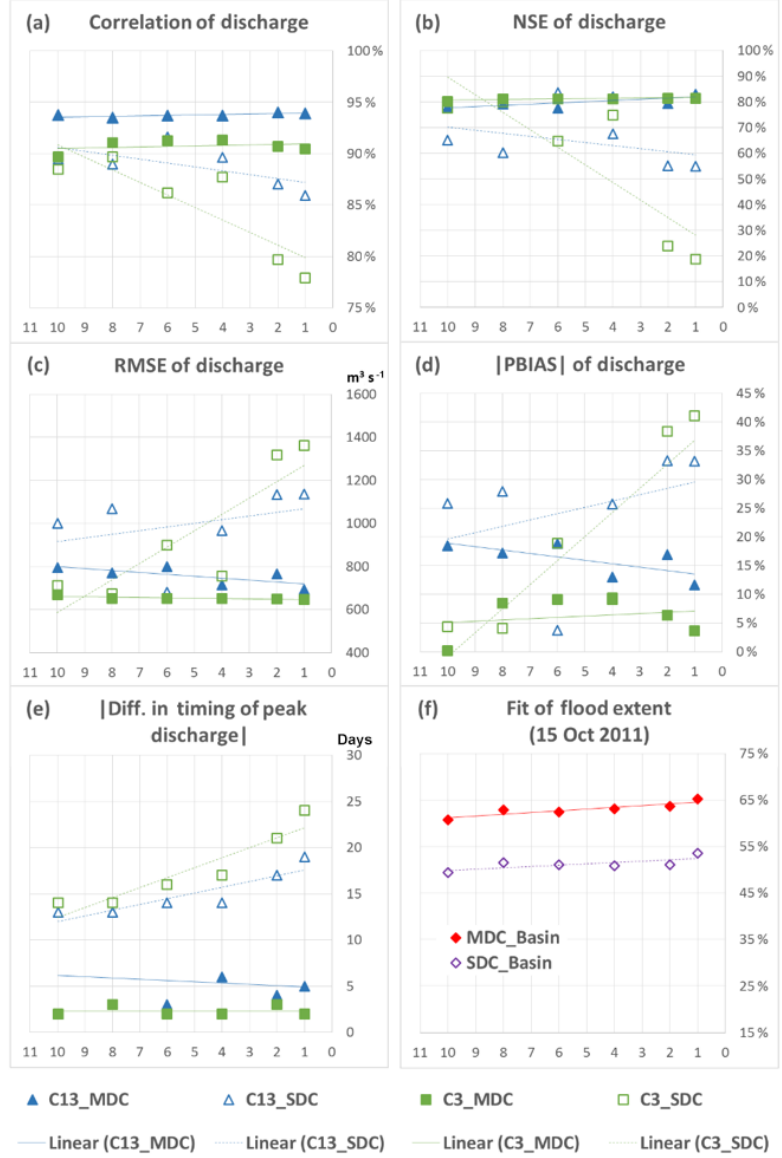
Figure 5. Model efficiency at varying spatial resolution and varying flow connectivity schemes. The statistics for discharge (correlation, RMSE, percent bias, NSE coefficient, and difference in peak timing) were calculated and compared with the naturalized discharge at corre- sponding gauge stations. The fit of flood extent was calculated for the entire